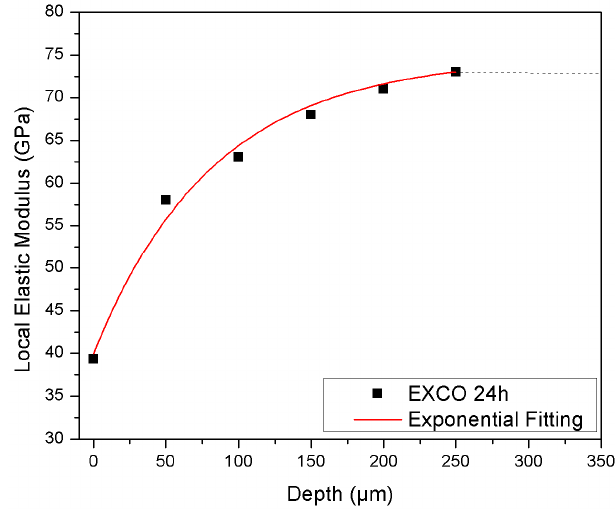
Figure 4. Evolution of HEZ’s local elastic modulus with depth and exponential fitting of local elastic modulus values, for 24 h exposed specimens.